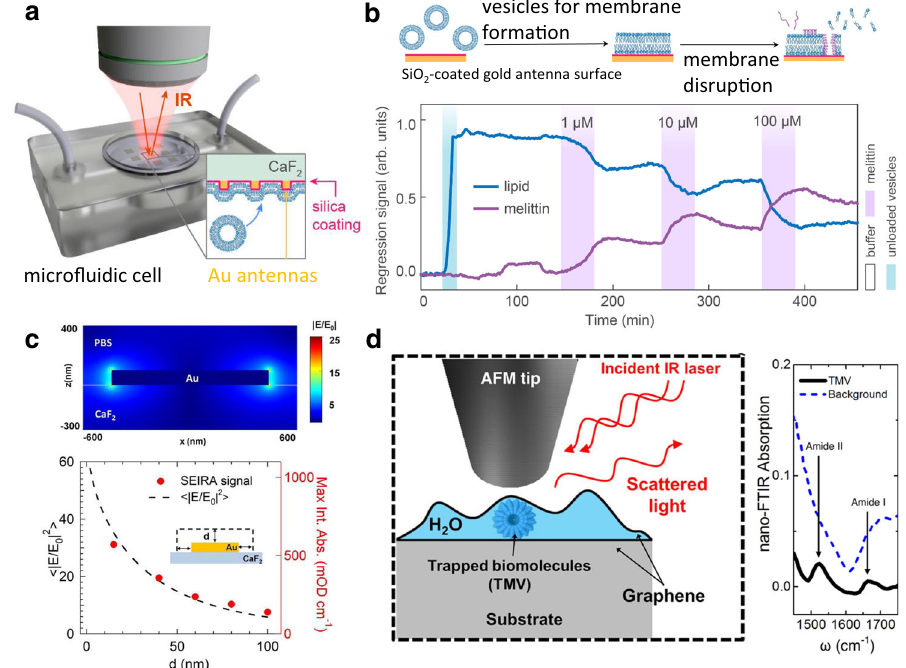
Fig. 3 Detecting biomolecules with mid-IR spectroscopy. a Re fl ection-mode in situ SEIRA detection of multiple biological analytes. b Time-resolved and molecule-speci fi c in situ SEIRA monitoring of the lipid membrane formation and disruption dynamics. Lipid vesicles rupture on SiO 2 -coated gold antennas and form a supported lipid bilayer membrane. Subsequent injection of cytolytic peptide, melittin, forms pores and disrupts the membrane. a , b Adapted from ref. 47 with permission. c Calculated electric fi eld enhancement for a gold nanotenna in a buffer. Distance dependence of SEIRA signal comparing computer simulations (dotted) and measured absorbance data (full dots). Reprinted from ref. 48 with permission. d Graphene liquid cell for detection of biomolecules trapped in a thin layer of water. Reprinted from ref. 50 with permission.